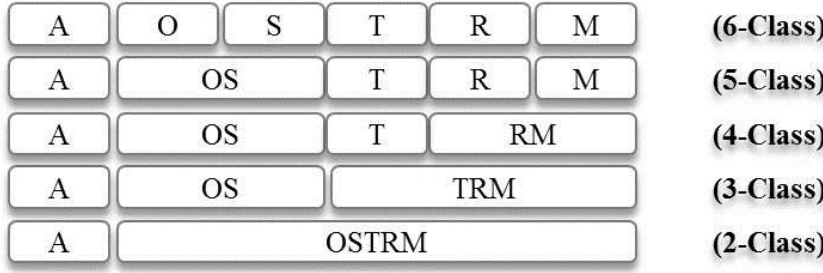
Figure 2. Different levels of the initial master 2013 classification from 2 classes to 6 classes. Only the initial 2013 classification had 6 classes—the initial classification of every other yearly classification started with 5 classes because Open and Stand Initiation were too similar to separate at this stage of the study. A = Alpine, O = Open, S = Stand Initiation, T = Thin, R = Advanced